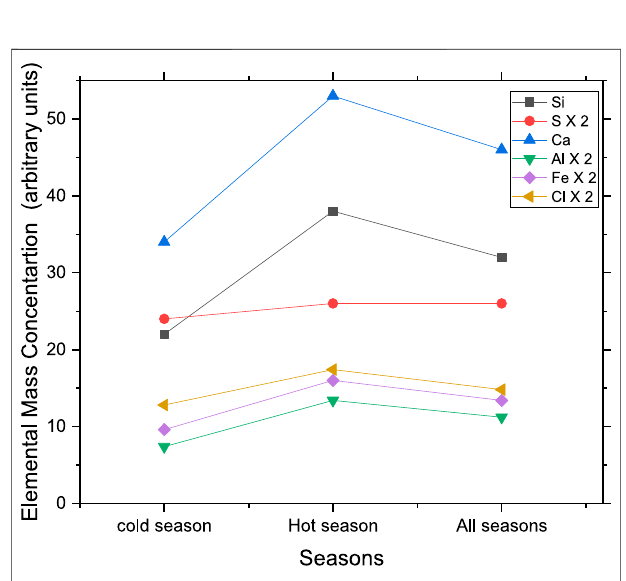
FIGURE 4 | Seasonal variation ofelemental concentrations for the major elements originating from natural sources and for S, which is an anthropogenic source. The mass concentrations of S, Al, Fe and Cl are multiplied by a factor of 2 for clarity.